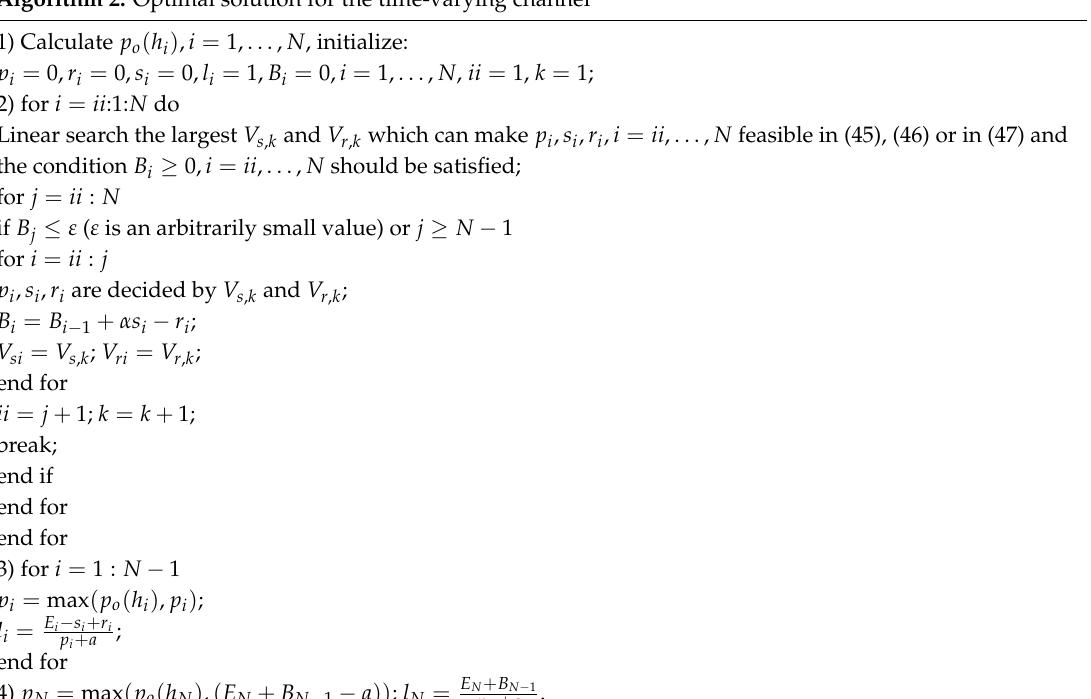
Algorithm 2. Optimal solution for the time-varying